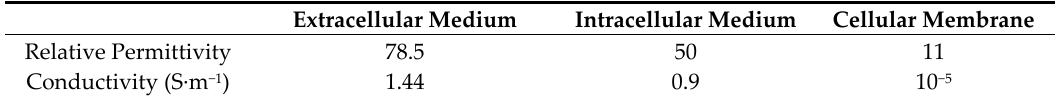
Table 1. The dielectric properties of RBC.